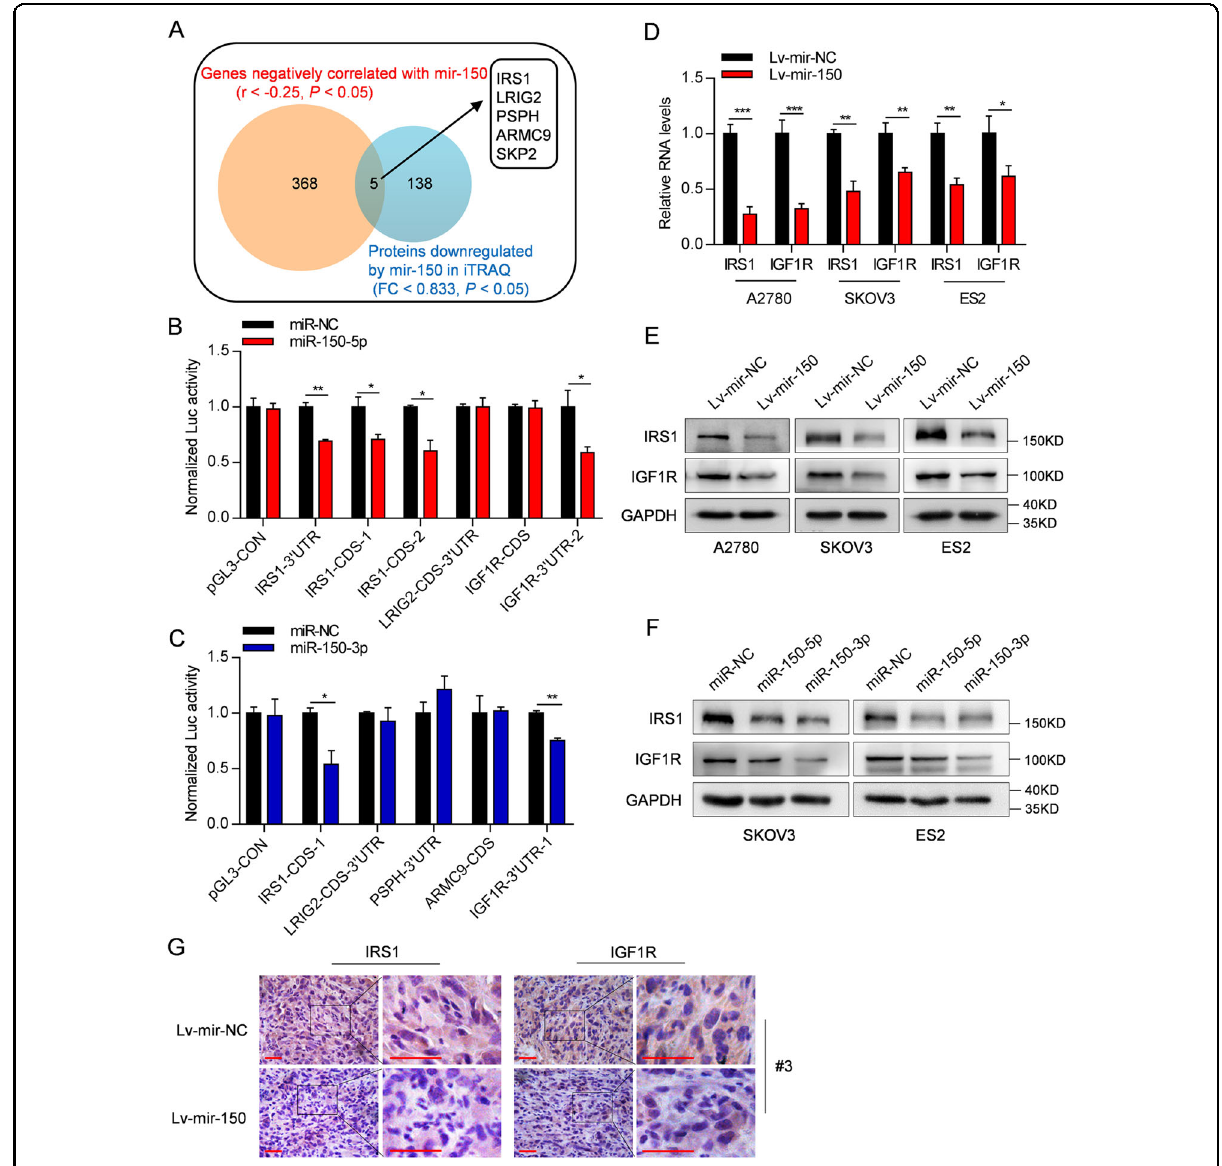
Fig. 4 IRS1 and IGF1R are directly targets of miR-150-5p/3p. A Venn diagram depicting the number of the proteins signi fi cantly downregulated (blue) (FC < 0.833, P < 0.05) in Lv-mir-150-A2780 cells shown in iTRAQ analysis and the number of protein-coding genes negatively correlated with mir-150 (orange) ( r < − 0.25, P < 0.05) in 265 OC tissues from TCGA. B , C Luciferase activities were measured in HEK293T cells transfected with reporter plasmids containing the predicted binding sites, together with miR-150-5p ( B ), miR-150-3p ( C ) or control mimic. D , E Relative mRNA ( D ) and protein ( E ) levels of IRS1 and IGF1R in Lv-mir-150-OC cells were measured by real-time RT-PCR and western blot analyses. F The protein levels of IRS1 and IGF1R in SKOV3 and ES2 cells transfected with miR-150-5p or miR-150-3p mimic. G IHC staining showed that the expression of IRS1 and IGF1R was reduced in xenografted tumors from Lv-mir-150-ES2 cells. Magni fi cation: ×400. Scale bar: 50 µm. The data are presented as the mean ± s.d. * P < 0.05, ** P < 0.01, *** P < 0.001 by Student ’ s t